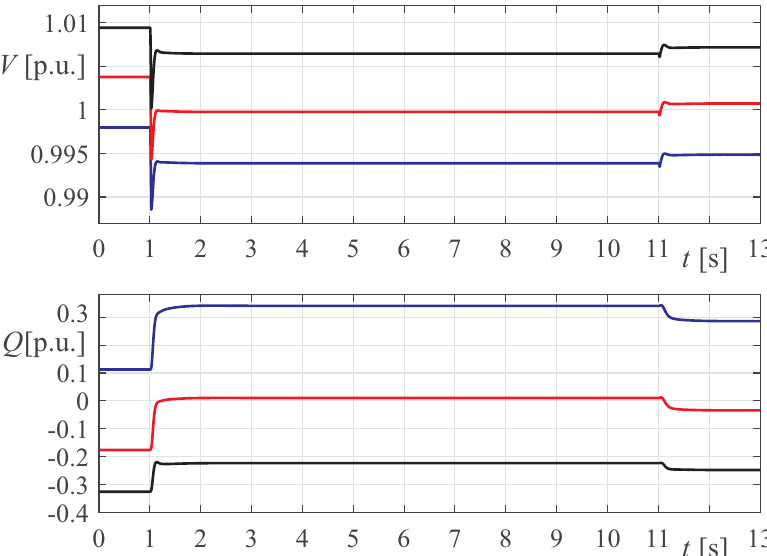
Figure 10. Second simulation, Feeder 2: time evolution of the nodal voltage amplitudes ( V 18 blue, V 21 red, V 24 black) and PV reactive powers ( Q DG